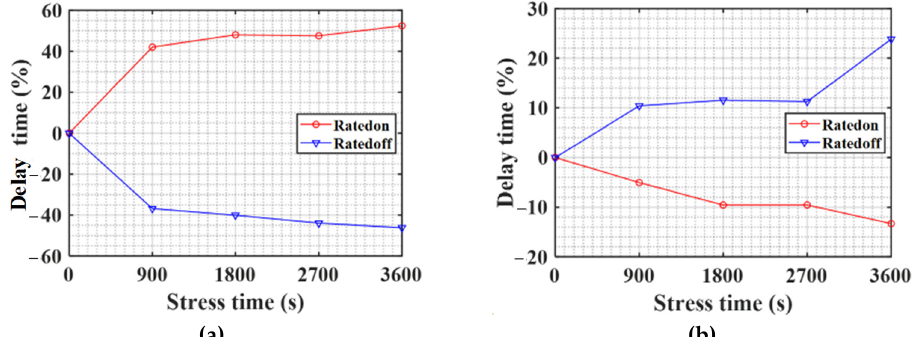
Figure 21. Rate don and Rate doff according to the stress time in PHEF and NHEF stress: ( a ) PHEF stress, and ( b ) NHEF stress.